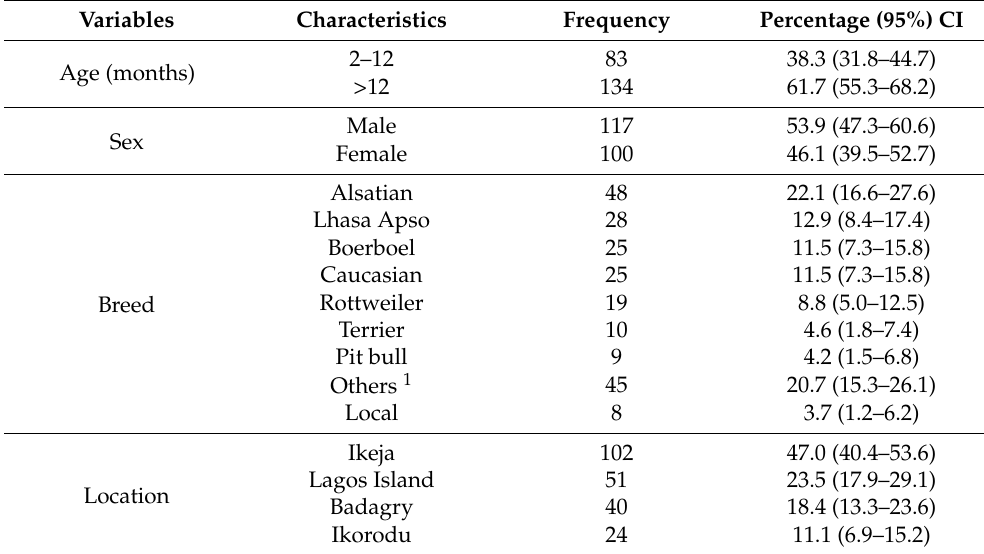
Table 2. Dogs characteristics ( n = 217) presented at veterinary clinics or hospitals in Lagos State, Southwest Nigeria, in